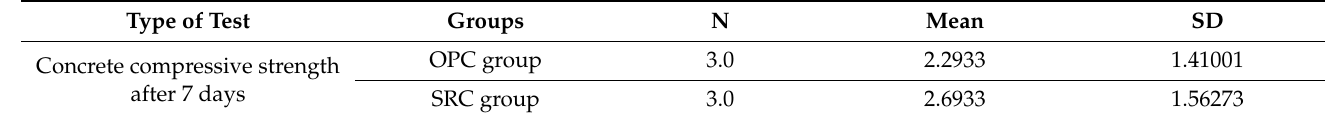
Table 8. Group statistics for concrete compressive strength test after 7 days.